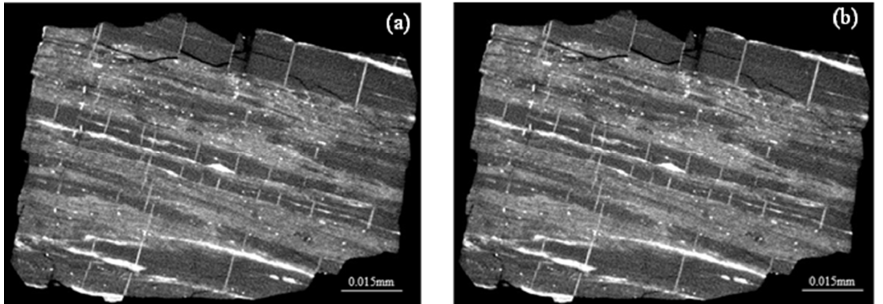
Figure 11. Two-dimensional slices of mineral filling fractures in sample BD-3 (( a ) is the first slice and ( b ) is the 45th slice; white means the fractures are filled with minerals).